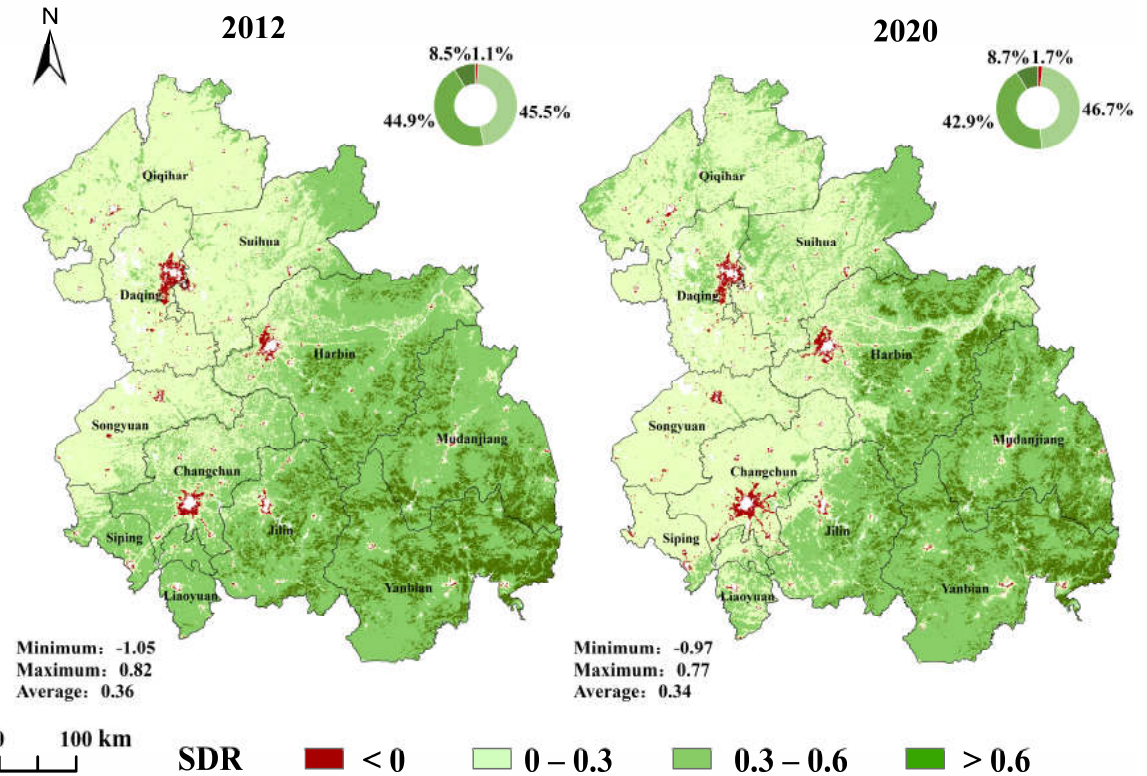
Figure 7. The spatial and temporal patterns of the carbon sequestration service supply–demand ratio